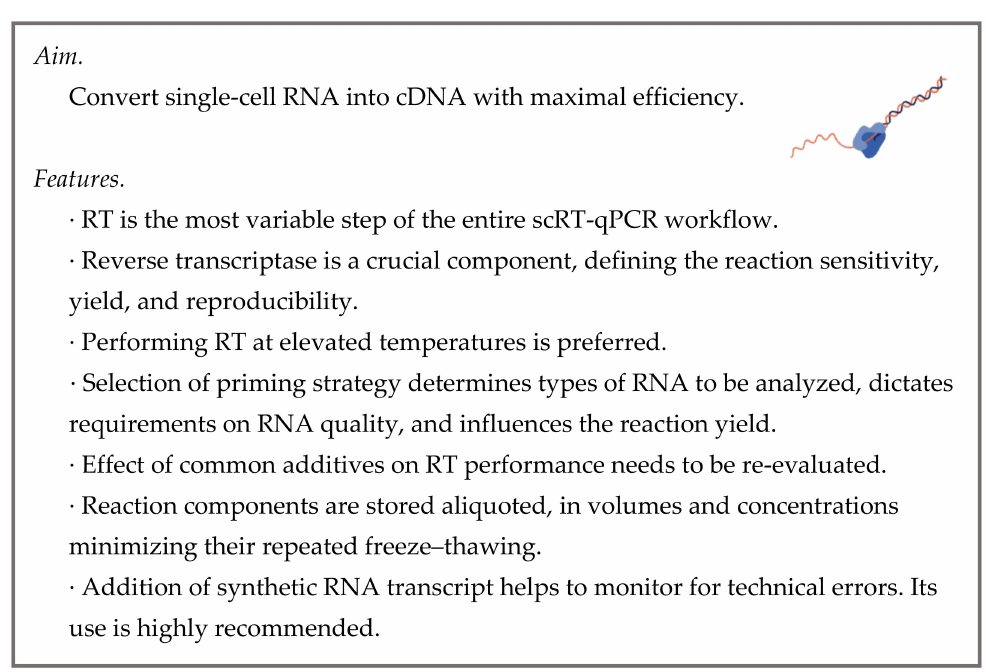
Figure 3. Reverse